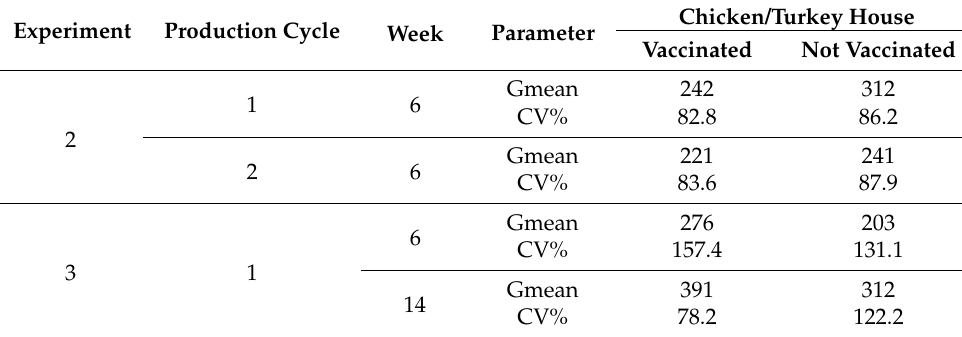
Table 4. Results of aMPV serological evaluation in E. coli vaccinated and control unvaccinated birds in experiments 2 and